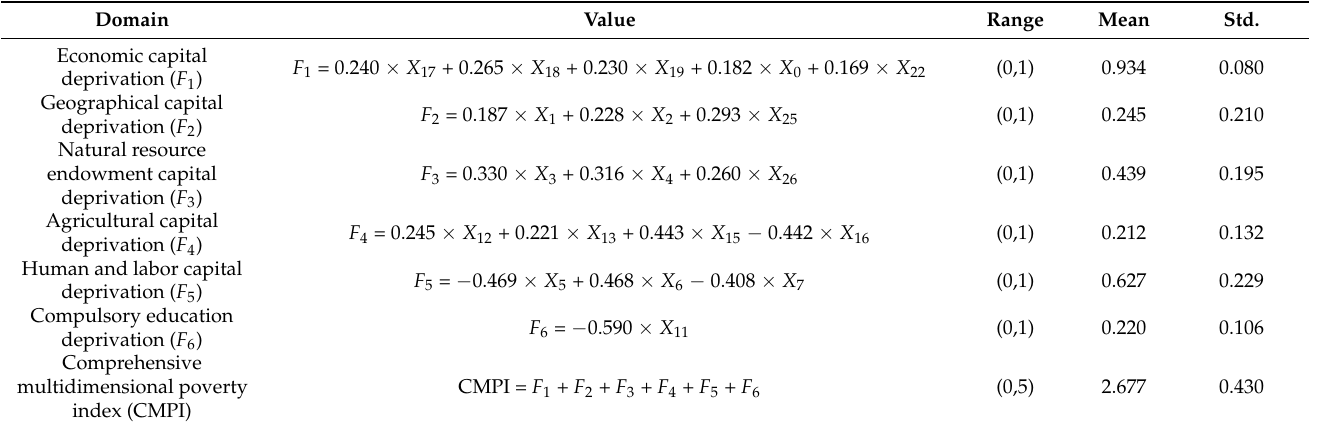
Table 5. Formulation of the CMPI and the six